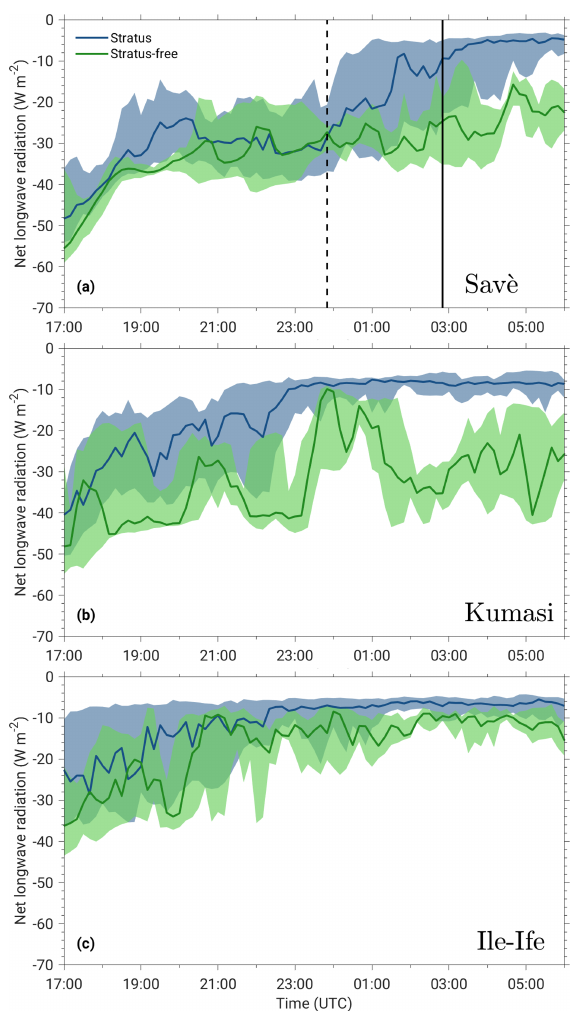
Figure 4. The net longwave radiation for stratus (blue) and stratus- free (green) nights measured at three supersites: (a) Savè, (b) Ku- masi and (c) Ile-Ife. The solid line shows the median, and the shading indicates the range between 25th and 75th percentile. In panel (a) , the vertical dashed line at 23:50UTC indicates the beginning of stratus fractus phase, while the solid vertical line (02:50UTC) corresponds to the stratus phase during cloudy nights.